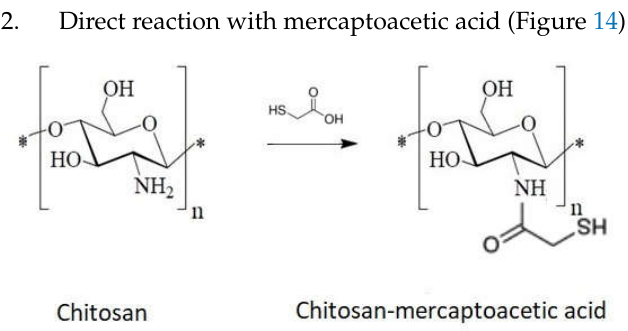
Figure 14. Schematic of chitosan sulfonation via mercaptoacetic acid. 3. Grafting of thiourea (Figure 15) via a cross-linking agent or by a chitosan reaction with ammonium thiocyanate [111,112]. Figure 15. Schematic of chitosan sulfonation via thiourea. 4. Grafting of sulfonic groups onto chitosan (Figure 16)